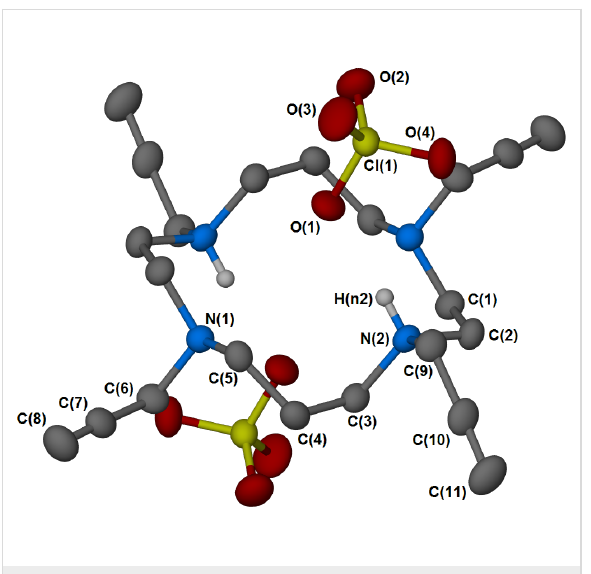
Figure 1: Ball-and-stick depiction of the crystal structure obtained for [( 3 )H 2 ](ClO 4 ) 2 , generated with X-Seed [51] and POV-Ray [52]. Ellip- soids shown at 50% probability. The asymmetric unit consists of one half of the ligand and one perchlorate